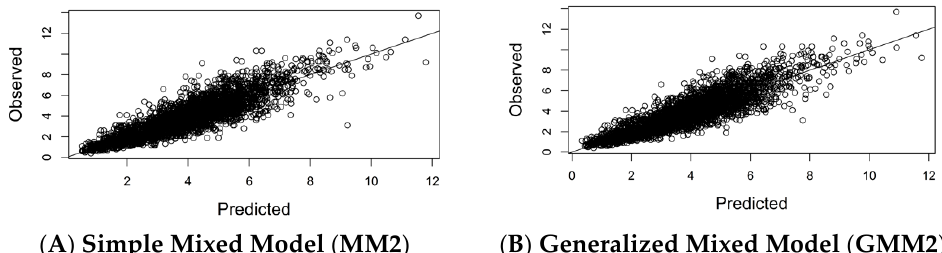
Figure 6. Comparison of the two modelling strategies, simple mixed model ( A ) and generalized mixed model ( B ).